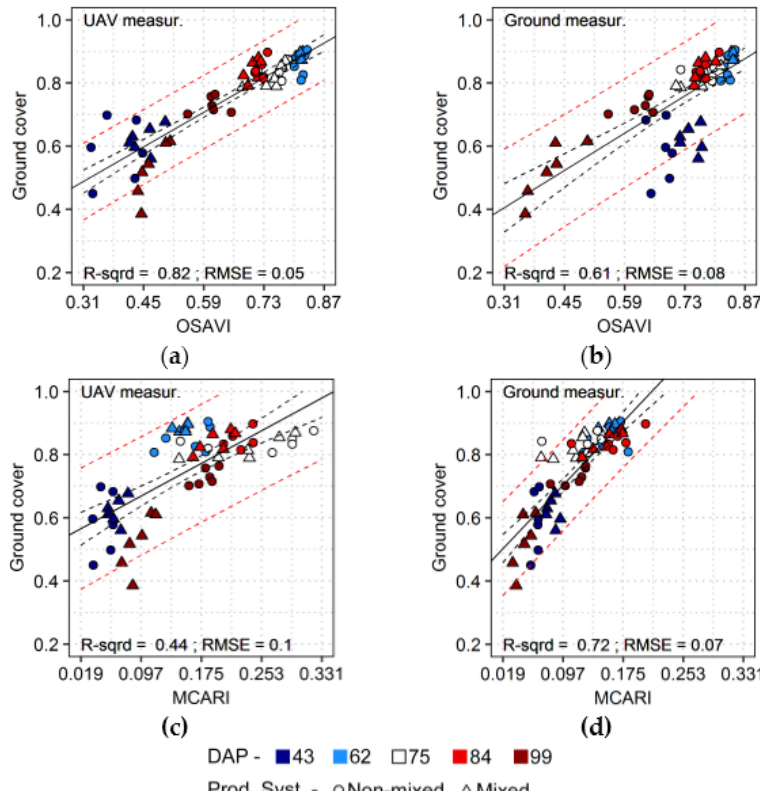
Figure 9. Best vegetation indices for prediction of ground cover from UAV and ground-based data ( a , d , respectively) and corresponding results for ground-based and UAV measurements ( b , c , respectively). Red and black dashed lines indicate prediction and confidence intervals with 95% confidence level, respectively.